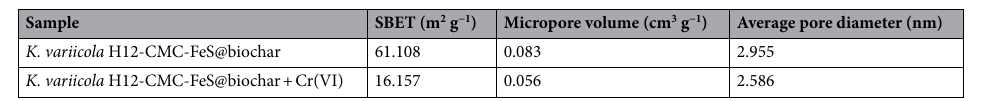
Table 2. Structure properties of K. variicola H12-CMC-FeS@biochar before and after treatment of Cr(VI).